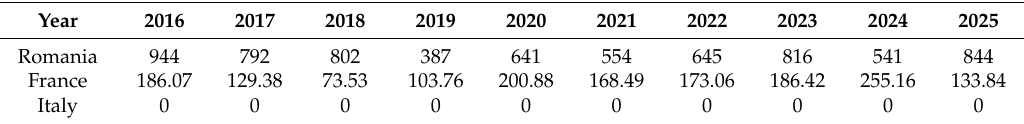
Table 12. The biodiesel potential for sunflower (thousand tons). Source: authors’ own calculation based on [56].